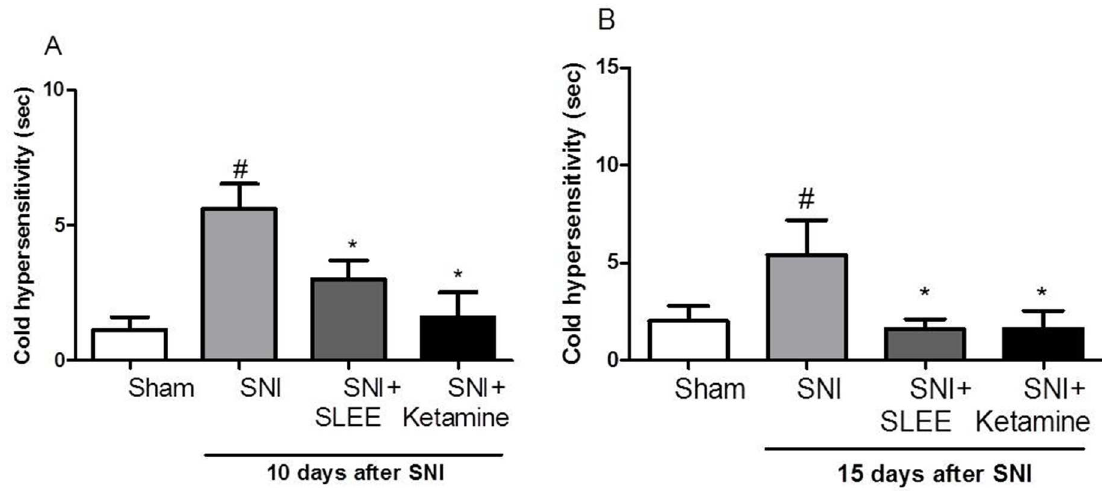
Fig 3. Effect of the oral administration of SLEE on SNI-induced increasedcold sensitivity in rats. The groups received Sham, SNI, SNI+SLEE (100 mg/kg, p.o.), or SNI+ketamine (10 mg/kg, i.p.). In (A, B), bars represent the time of the responseto cold stimulus on the 10 th day after SNI. In (B), bars represent the cold sensitivity on the 15 th day after SNI. The bars express the mean ± SEM(n = 8) comparingthe SNI vs. treated ( * P < 0.05) or sham ( # P < 0.05)